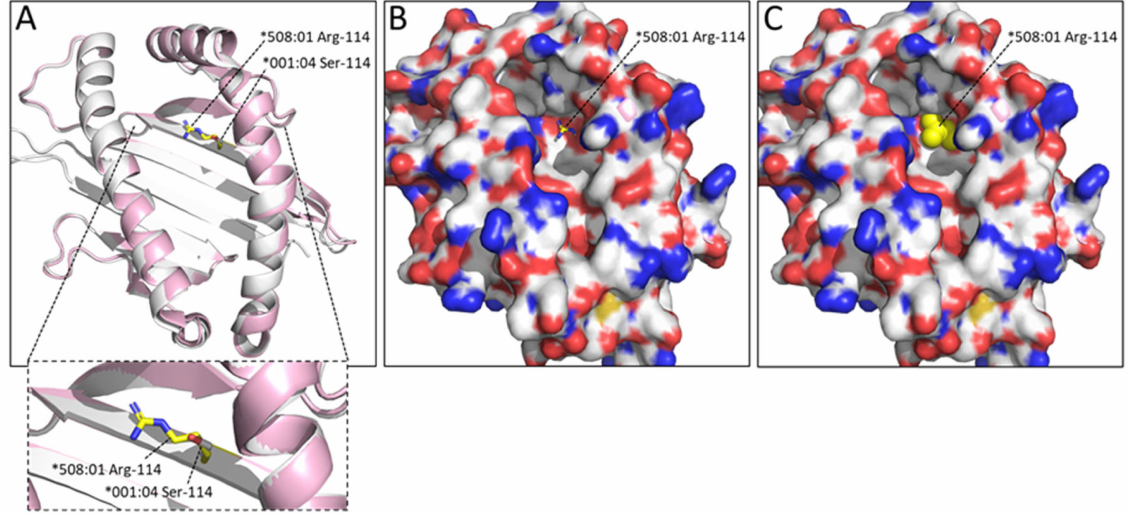
Figure 5. The Ser-114 residue in pDLA-88*001:04 leaves considerably more space in the E pocket than the Arg-114 residue found in pDLA-88*508:01 (PDB accession 5F1I). Superposition of α 1 α 2 domains: (( A ), with zoomed-in view) pDLA-88*001:04 in white and pDLA-88*508:01 in pink, with the sidechains of their Ser-114 and Arg-114 residues in sticks format and white and yellow element coloring, respectively; ( B ) same as ( A ), but with the DLA-88*001:04 α 1 α 2 domain shown in surface format with element coloring; ( C ) same as ( B ) but with the DLA-88*508:01 Arg-114 sidechain shown in all-yellow spheres format, revealing how this residue decreases the space available in the E